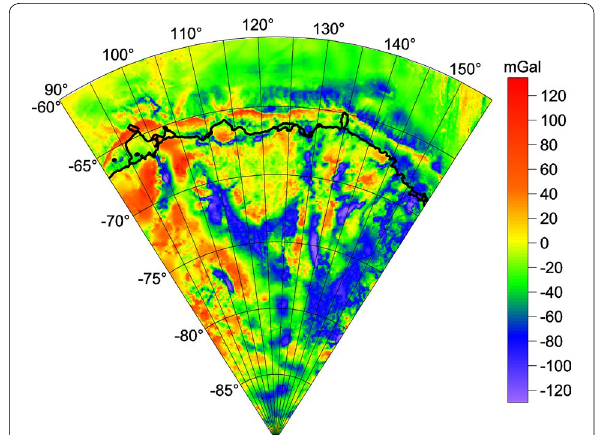
Fig. 8 I 1 [s − 4 ] in the Wilkes Land anomaly area, using the RET 14